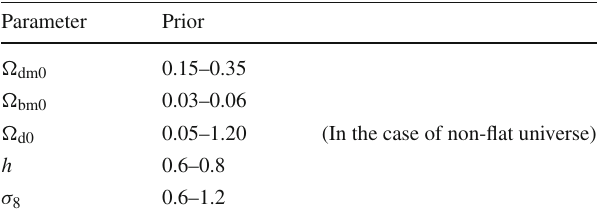
Table 1 The ranges of the model parameters which we consider in this work as the prior. We note that we assumed uniform priors for all of the model parameters. Notice that (cid:4) dm0 and (cid:4) bm0 represent the present values of energy densities for dark matter and baryons, respectively. The energy density of total non-relativistic matter is sum of dark matter and baryons as (cid:4) m = (cid:4) dm + (cid:4)